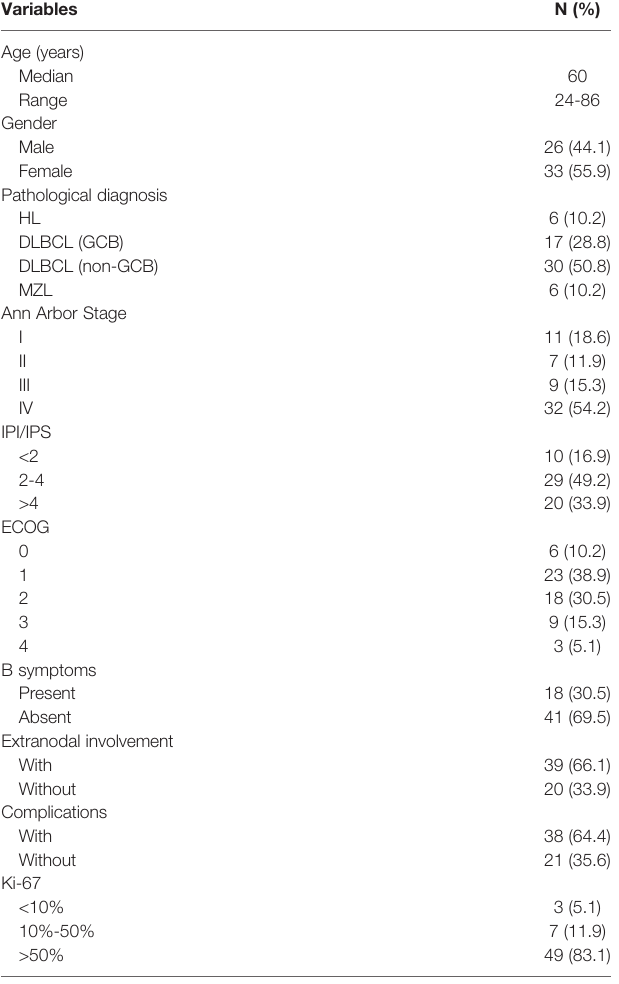
TABLE 1 | Baseline characteristics of all